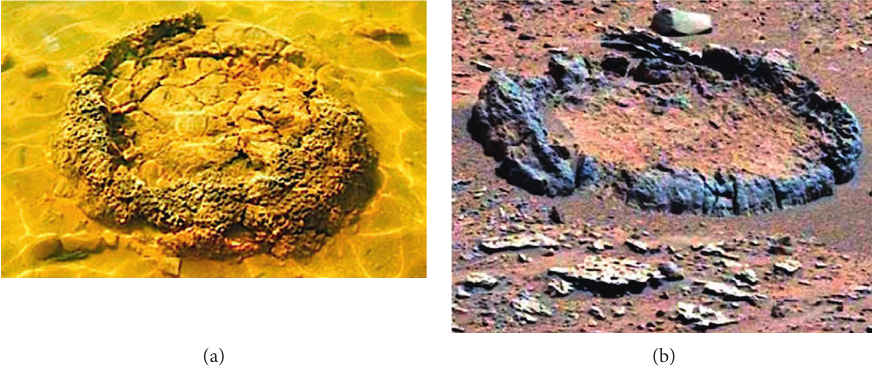
Figure 3: (a) Submerged Lake Thetis stromatolite. Photo credit: government of Western Australia department of mines and petroleum. (b) Sol 122: Martian specimen with collapsed dome and evidence of fossilized fenestrae within the upper portion of the walls. This specimen appears to be fossilized and displays the vertical and inward orientation typically caused by upward-migrating microbial colonies at the sediment-water interface (Figure 4). Several “peanut-brittle” specimens resembling thrombolite mats appear in the bottom portion of the